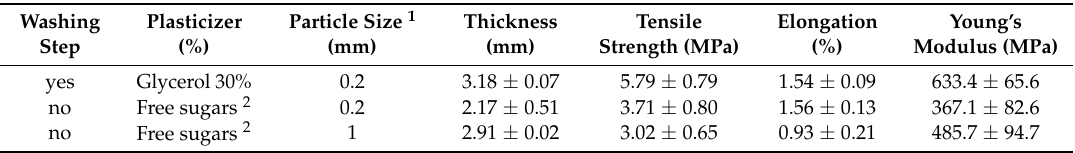
Table 3. Different preparation conditions and main features of fiberboards prepared from apple pomace applying 8 MPa pressure for 20 min at 100 ◦ C.